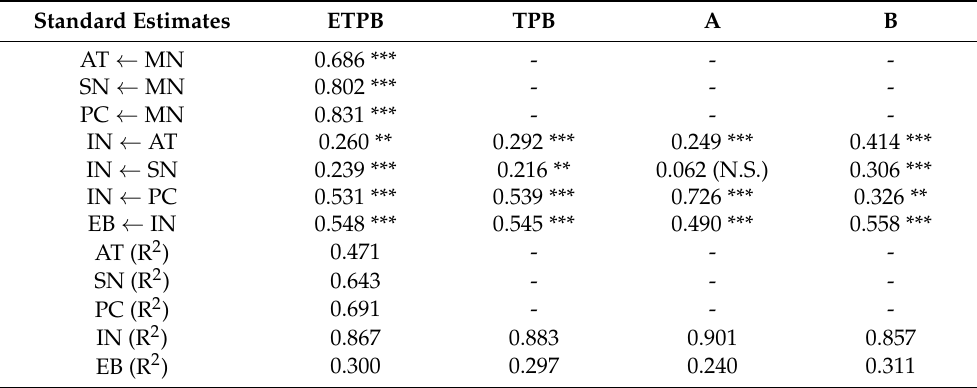
Figure 2. Standard estimates for expanded Theory of Planned Behavior (Model ETPB). Table 7. Standard estimates for various models.